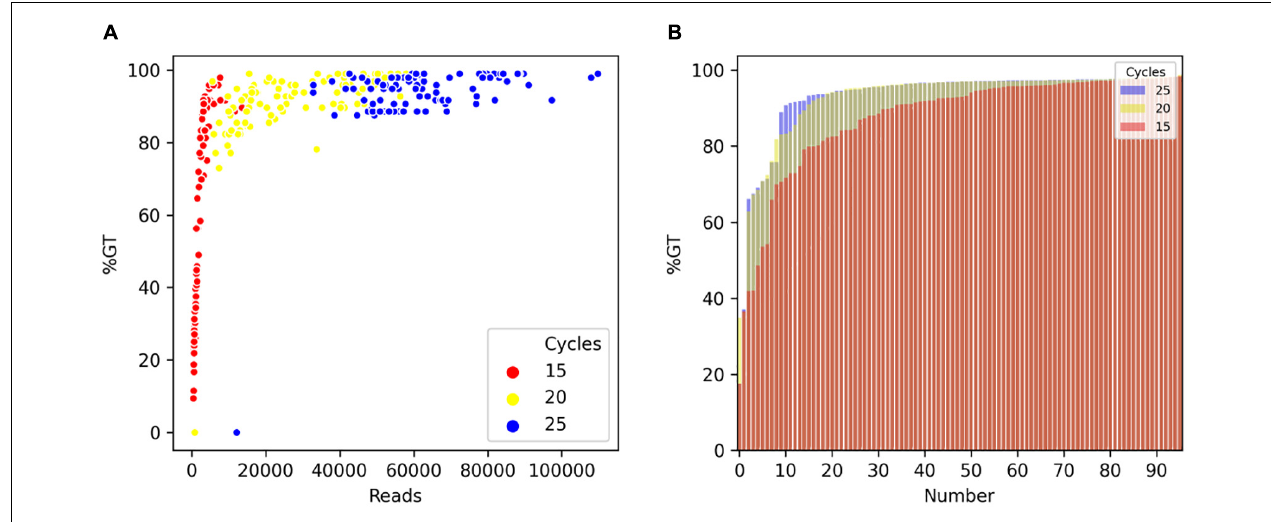
FIGURE 3 | Comparison of genotyping rate as a function of the number of PCR cycles. (A) Scatterplot of genotyping rate (%GT) as a function of read number after 15 (red), 20 (yellow), or 25 (blue) PCR cycles. (B) Genotyping rate of loci in the panel. Number of PCR cycles: 15 (red), 20 (yellow), or 25 (blue).